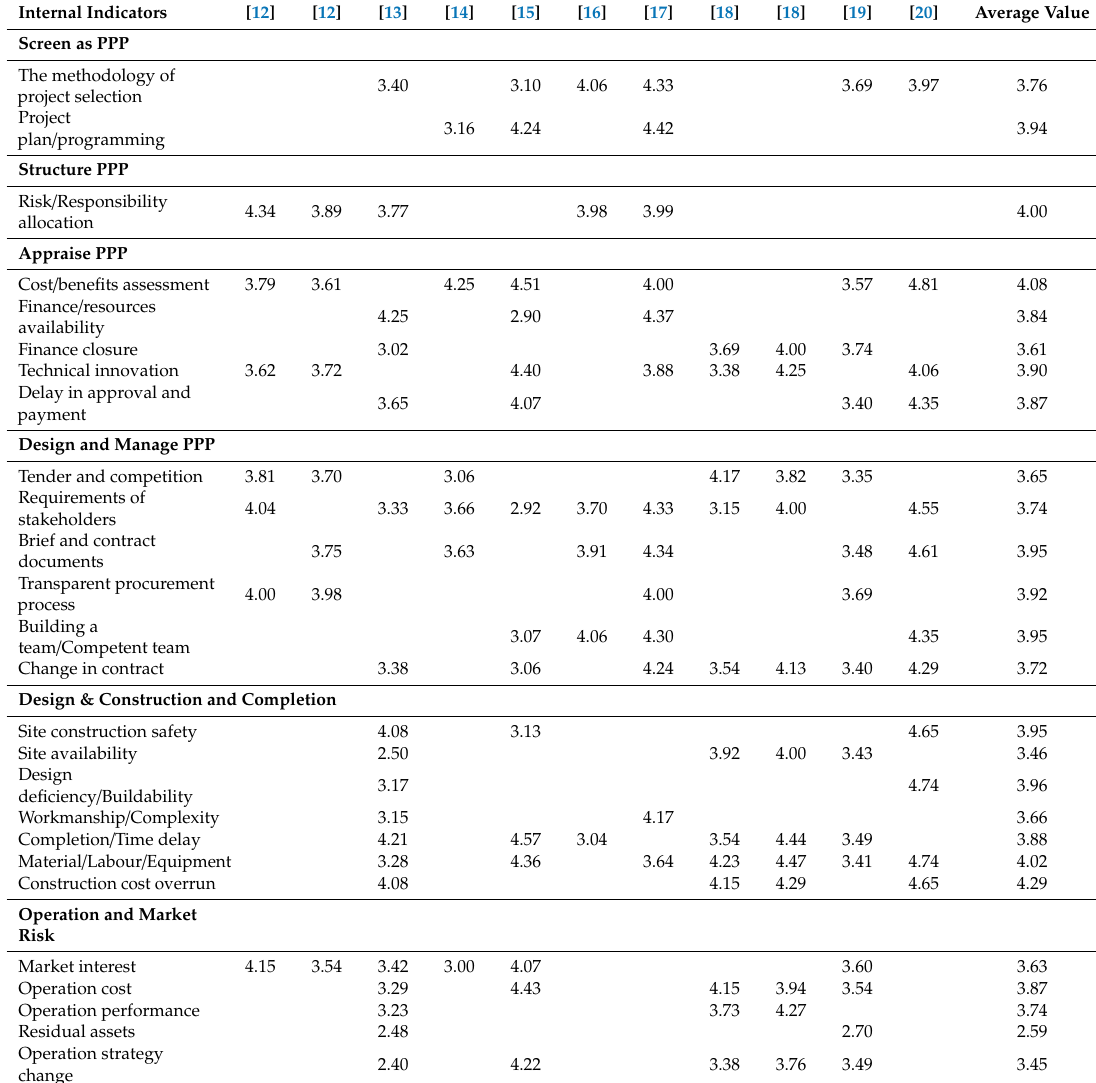
Table 2. Overview of PPP project internal indicators in recent research articles with the mean values of importance. Source: selected literature. The classification catalogue is based on the World Bank Group PPP